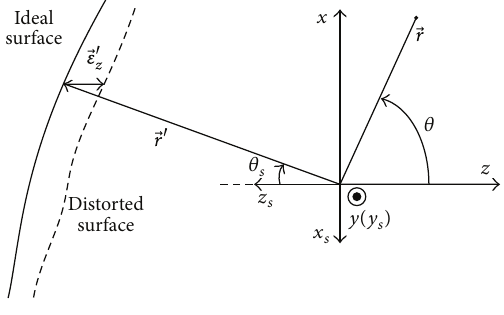
Figure 1: A distorted